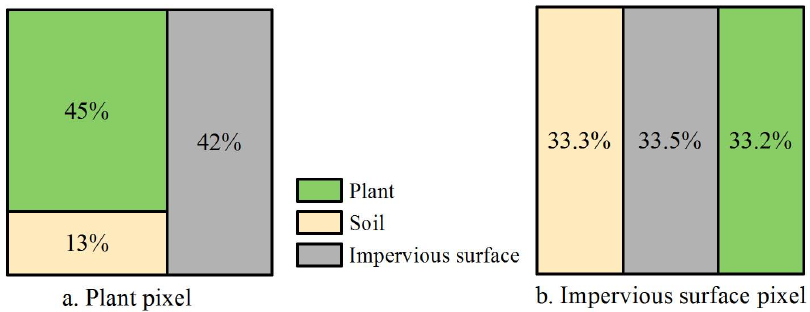
Figure 4. Classification of mixed pixels based on end-member contributions. The square represents a 30 m × 30 m